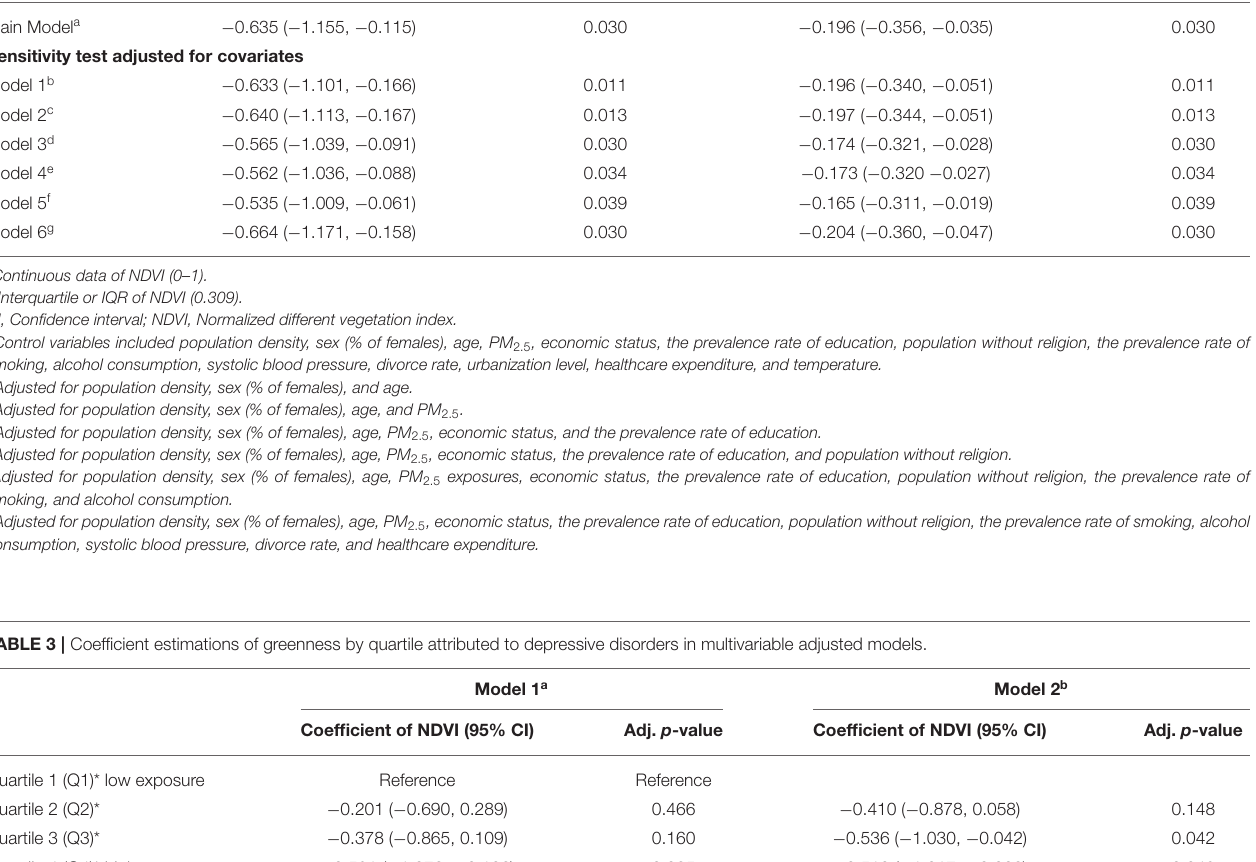
TABLE 2 | Association models between greenness and depressive disorders in the DALY changes per unit increment of NDVI, supported by stratified analysis. Model